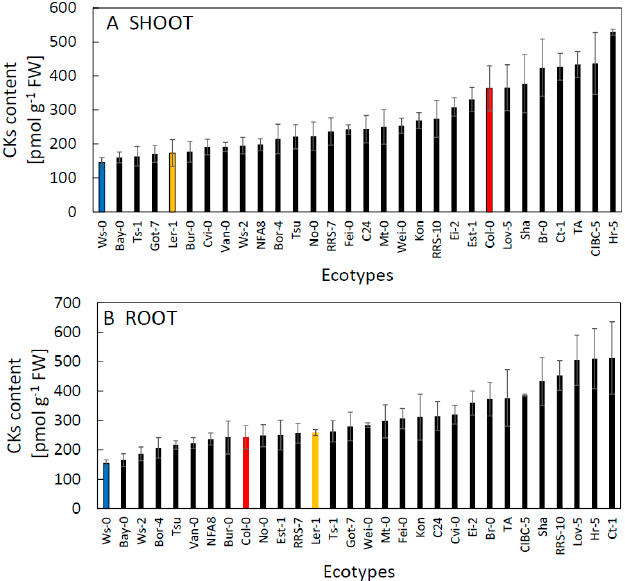
Figure 1. The content of CKs in shoot ( A ) and root ( B ) of thirty A. thaliana ecotypes grown 21d in controlled conditions. Commonly used ecotypes are marked in colour (Red = Col-0, Blue = Ws-0, Orange = Ler-1). See Table 1 for the full list of ecotypes. Means ± SD.